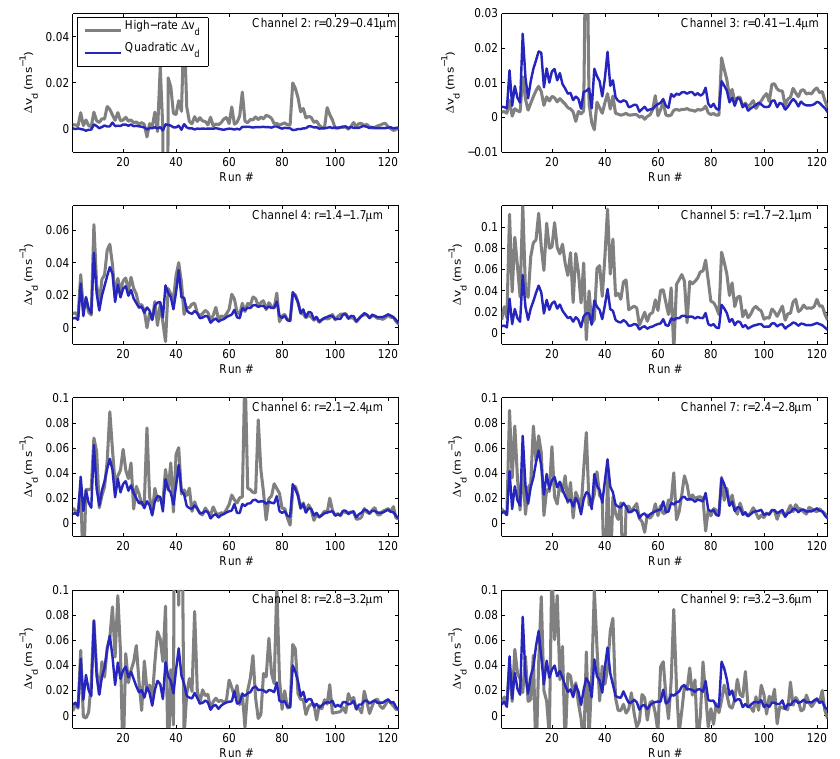
Fig. 11. Apparent deposition velocity due to hygroscopicity, 1v d , calculated through K01’s method, modified to use a log-linear quadratic functional form, and the difference in high-rate deposition velocity between raw and RH-corrected (to run mean) spectra. CLASP channels 2–9 are